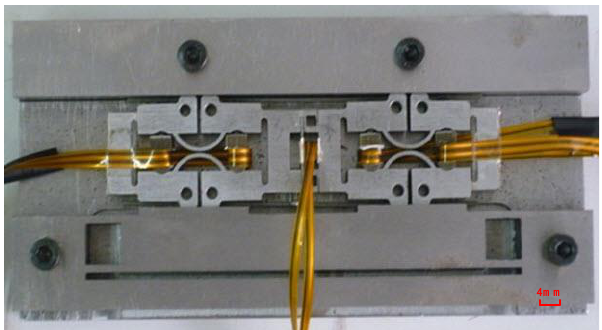
Figure 9. Picture of the prototype.